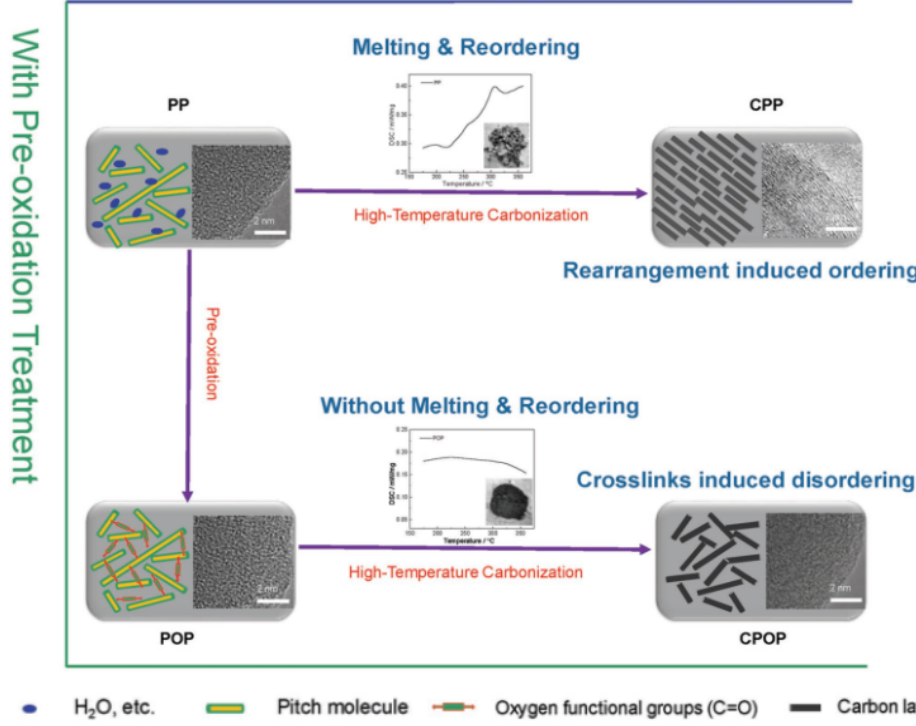
Figure 17. Schematic illustration of the carbon with or without the pre-oxidation treatment, in- cluding DSC curves and SEM images with the schematic diagram [26]. DSC curves and SEM images with the schematic diagram